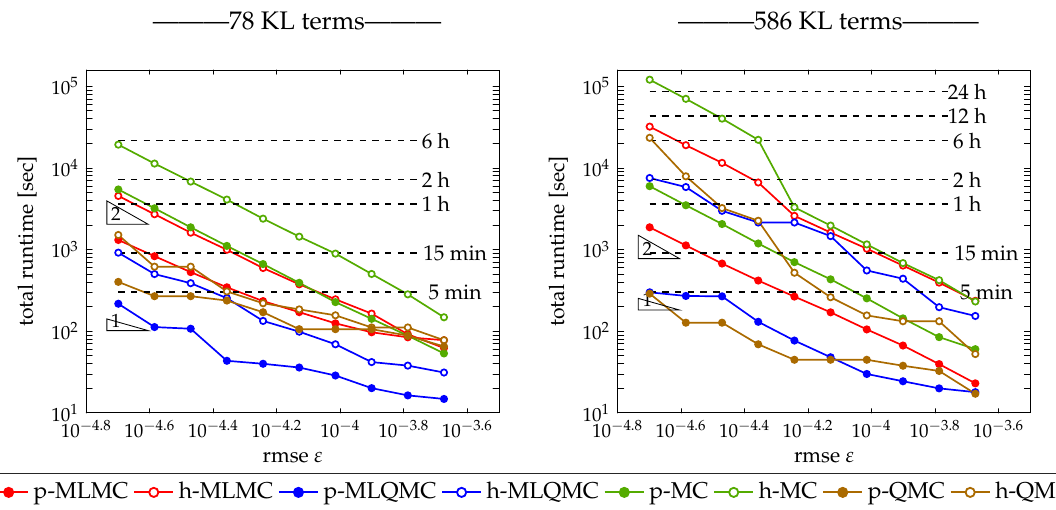
Figure 19. Runtimes for the different method in function of requested user tolerance for model problem 1.